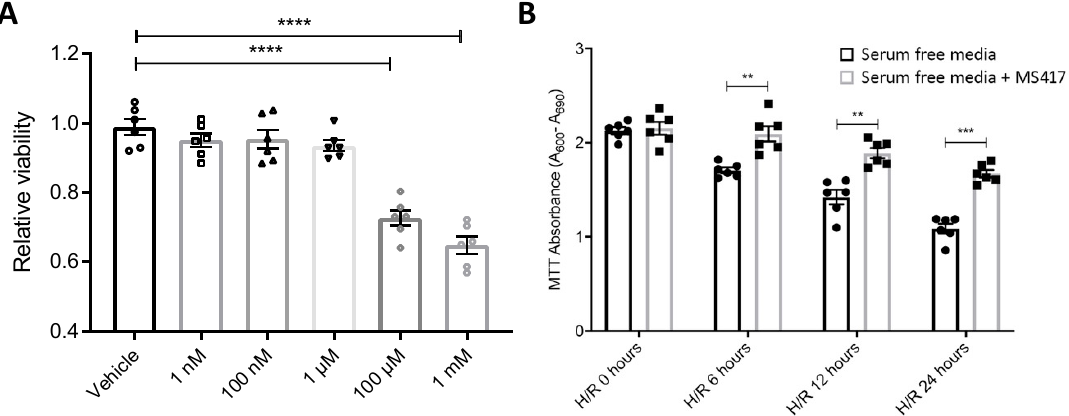
Figure 3. MS417 treatment had no effect on cell viability up to 1 μ M ( A ) BRD4 inhibition with MS417 had no effect on neutrophil cell viability at concentrations up to 1 μ M MS417. MTT Cell Viability assay was performed following treatment of isolated human neutrophils with 1nM–1 mM MS417 for 1 h. ( B ) BRD4 inhibition improves cell viability of HUVEC following H/R. HUVEC were exposed to 1% O 2 for 2 h followed by treatment with 1 μ M MS417 and 6, 12, and 24 h of re-oxygenation. Serum free media is in black, serum free media plus MS417 is in grey. Two-way ANOVA with Tukey was performed. n = 6, ** p < 0.01, *** p < 0.001, **** p < 0.0001.